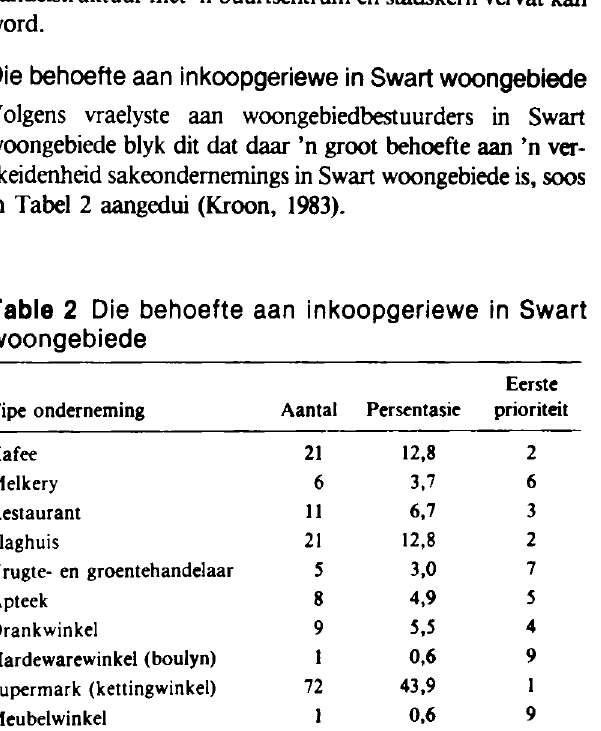
Table 2 Die behoefte aan inkoopgeriewe in Swart